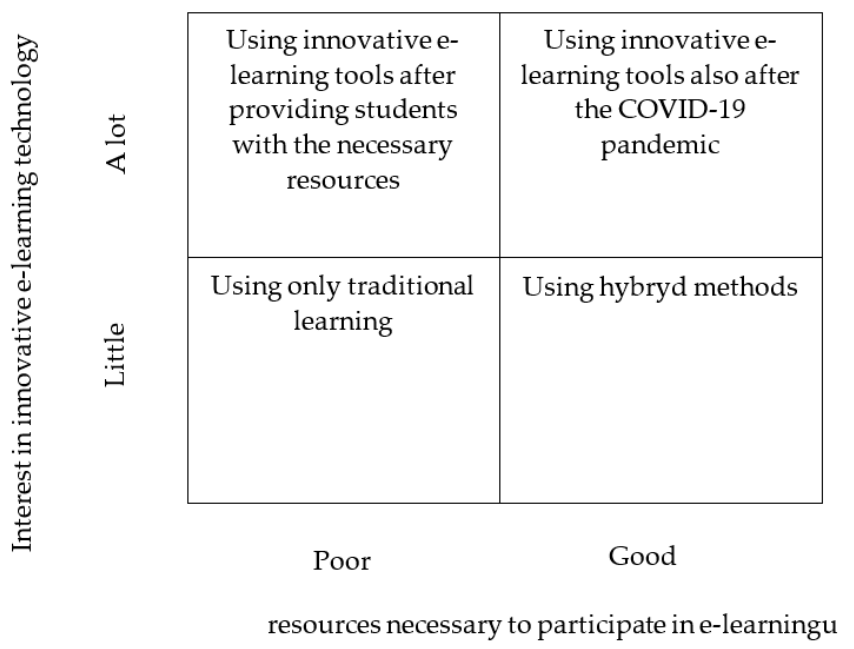
Figure 10. Model of using innovative e-learning tools for a group of students.